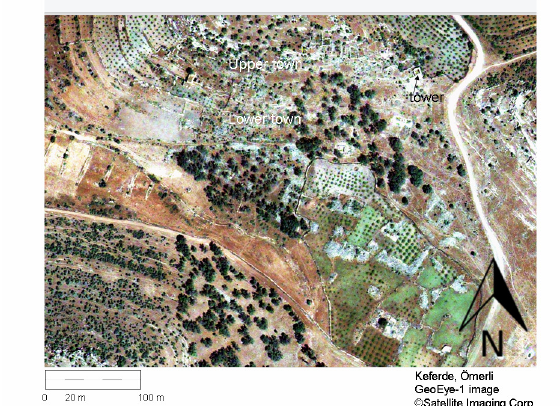
Fig. 4. The layout and structures of Keferde visible on a GeoEye-1 satellite image.